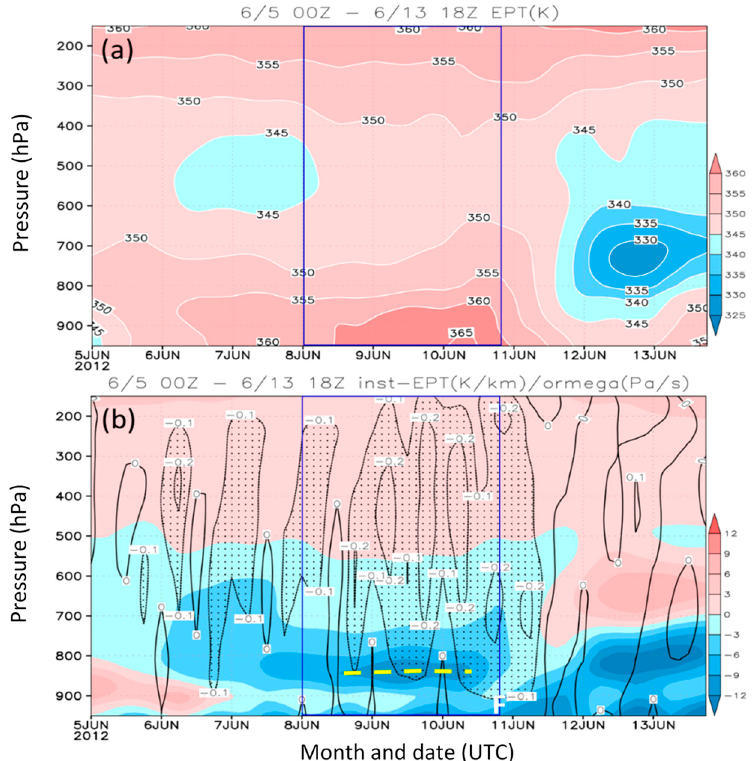
Figure 13. As in Figure 12, but showing the section of ( a ) equivalent potential temperature ( θ e , K, color with white isotherms very 5 K) and ( b ) potential stability ( ∂θ e/ ∂ z , K km − 1 , color) and rising motion in ω (= dp / dt , Pa s − 1 , contour every 0.1 Pa s − 1 and stippled for ω < − 0.1 Pa s − 1 ) in South China (red box in Figure 1), from 0000 UTC 5 to 1800 UTC 13 June 2012. The yellow dashed line in ( b ) marks the most unstable level.